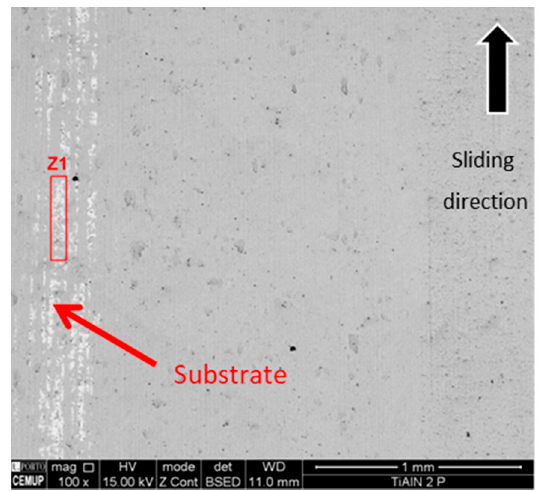
Figure 11. SEM image collected on the coated ring surface after tinplate contact during the wear tests.